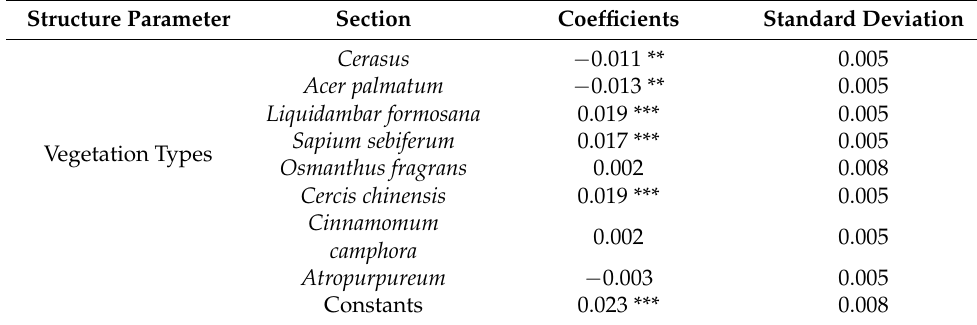
Table 4. Mean values of the regression model of canopy density, porosity, and cooling volume.